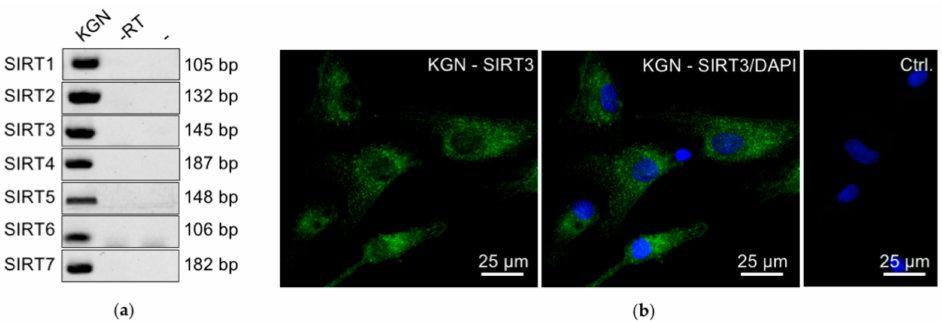
Figure 6. Results of RT-PCR analyses showing expression of SIRT1–7 in KGN cells ( a ). Immunofluo- rescence of SIRT3 (green) in KGN showed a prominent punctuate staining pattern in the cytosol ( b ) (Ctrl., control experiments, omission of first antibody; only nuclei are stained with DAPI (blue)).